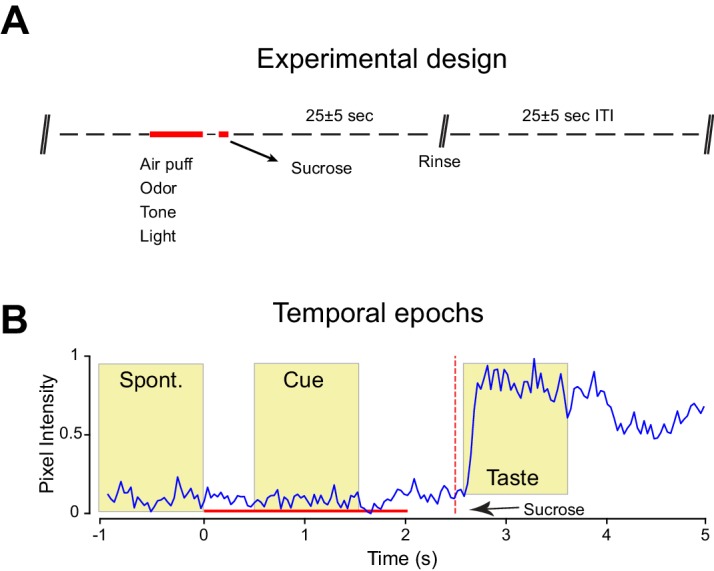
Experimental design for cue-taste association experiments and assessment of conditioned responses.(A) Schematic of the experimental design used for cue-taste Pavlovian classical conditioning. Red bars highlight stimulus delivery. Between cue-offset and the delivery of sucrose there is a delay of 500 ms. Each cue is presented in a pseudo-random fashion and always precedes the delivery of sucrose. Conditioning lasted 14 days with and every day each rat received 20 trials of each cue-sucrose pair. See experimental procedures for further details. (B) Representative record of mouth movements, averaged across trials (Cue is odor; the trace pertain to the first day of training) for a single session (first day of classical conditioning). Note the different temporal epochs used for assessing the time-course of classical conditioning. Sucrose is delivered through IOCs in aliquots of 40 µl. Each cross modal stimulus is presented for 2 s. Between the cross modal stimuli offset and sucrose onset there is a constant delay of 500 ms.